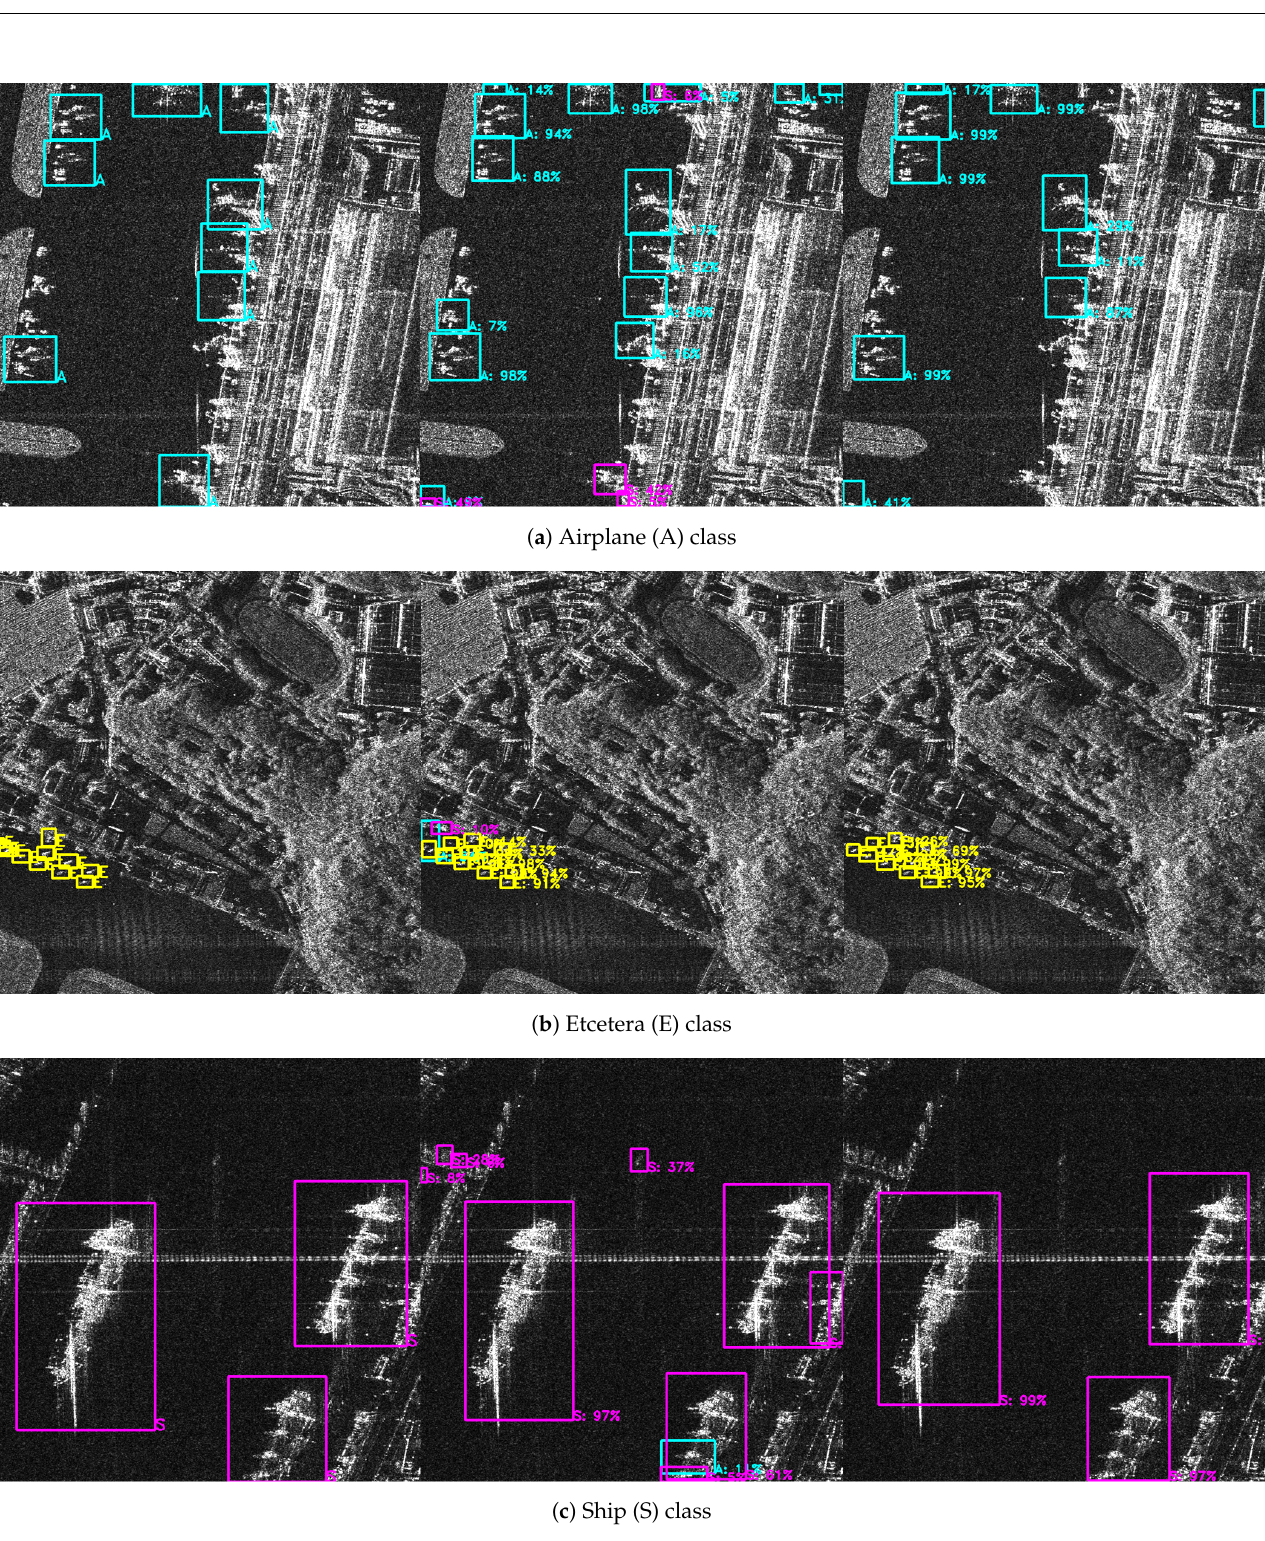
Figure 9. Image triples are shown in which the left image is groundtruth, while the middle image is for baseline models (traditional two-stage detection models with real SAR images), and the right image is for our models. The groundtruth and predicted bounding boxes are plotted in blue color for A class, yellow color for E class, and pink color for S class. The numbers on the bounding boxes in the middle and right images denote the confidence score for each corresponding category. We visualize all detected bounding boxes after NMS and thresholding detector confidence at